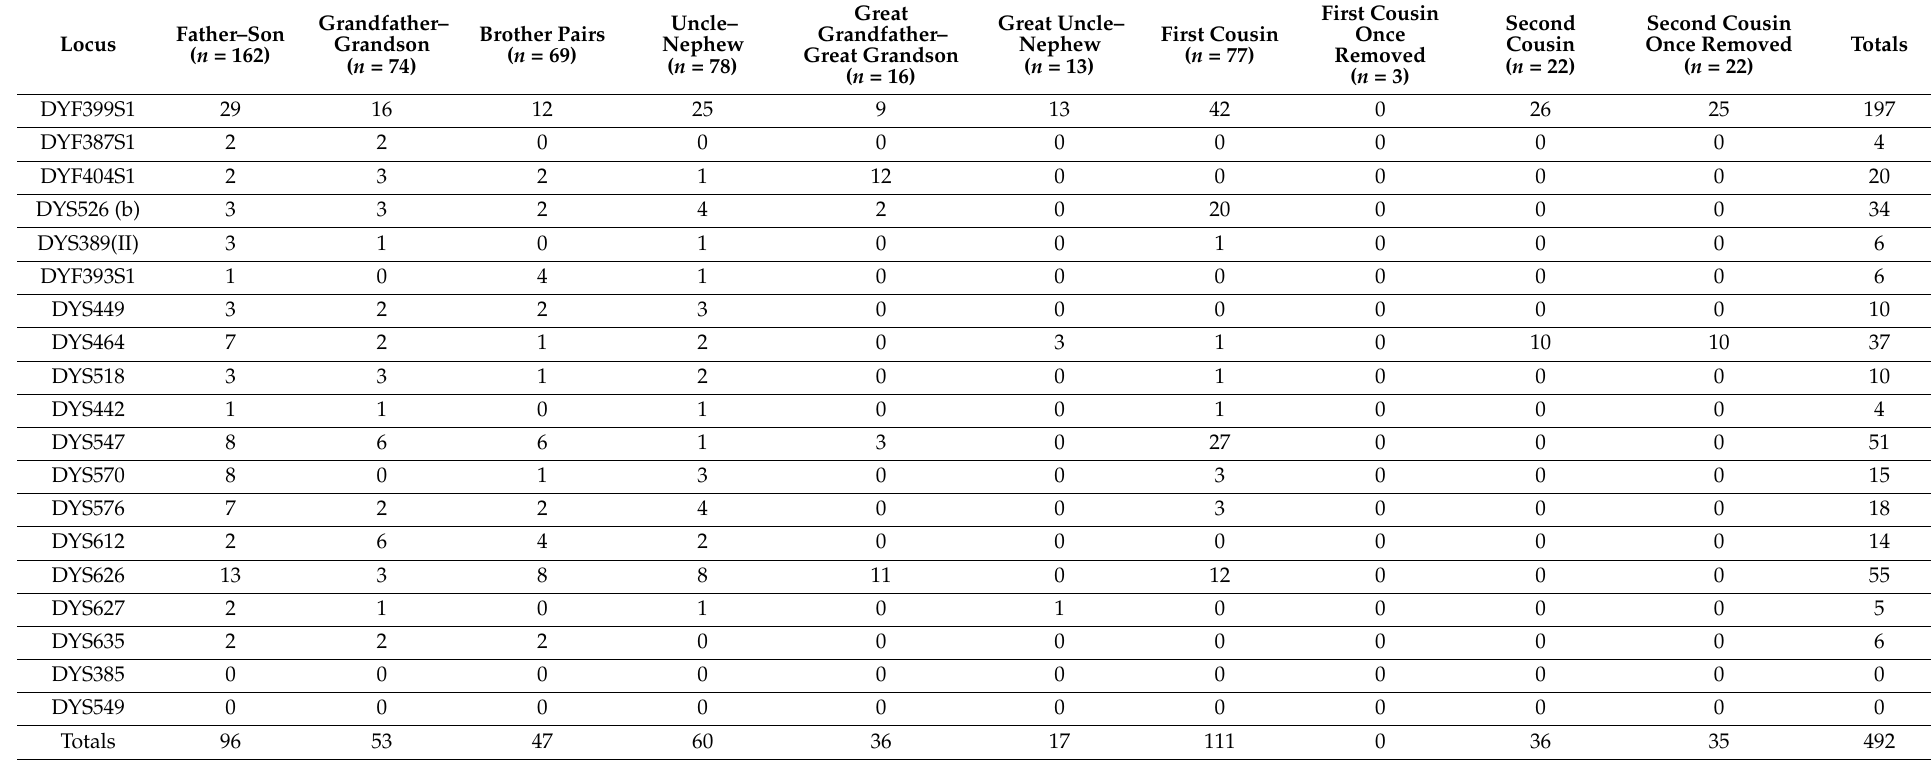
Table 3. Number of mutations identified at each RM Y STR in the studied pairs of male paternal